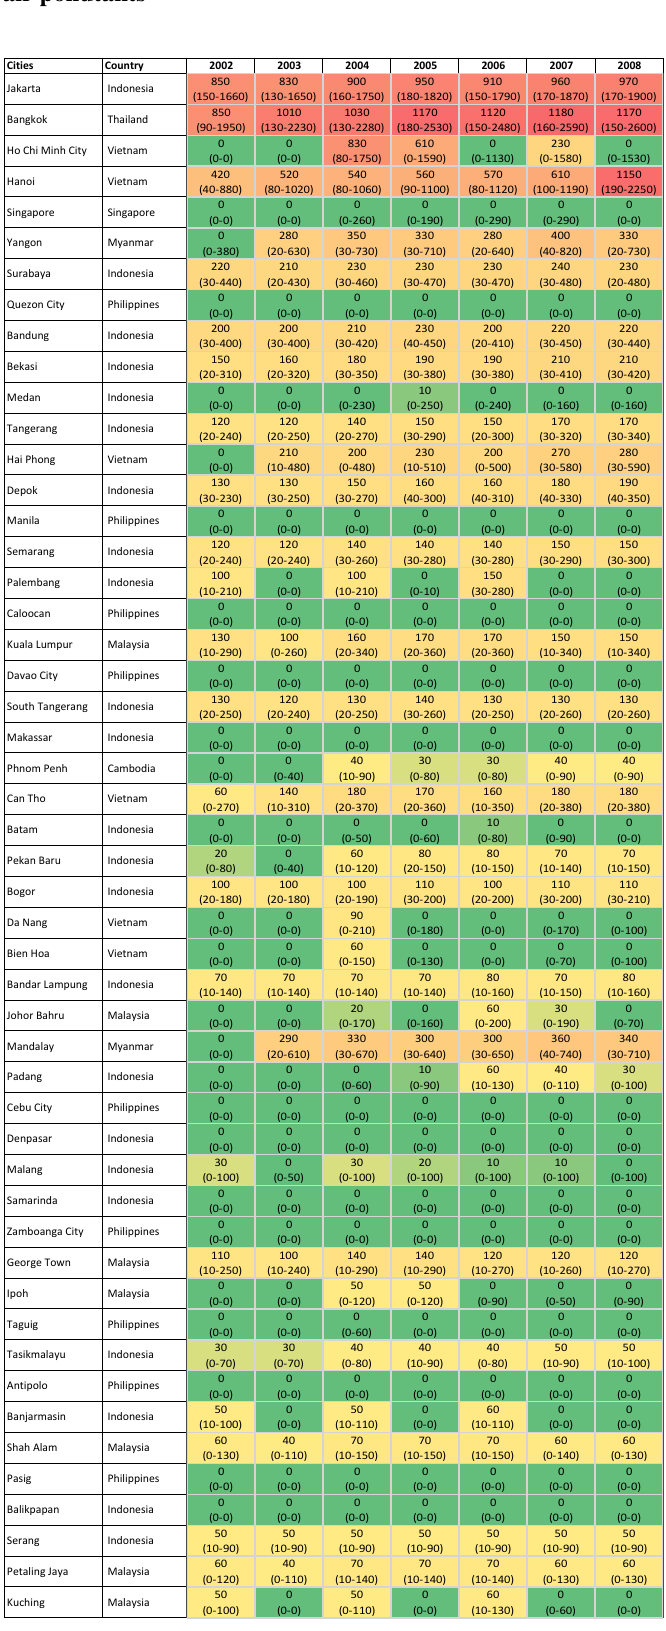
Figure 6. Premature mortality in different years from 2002 to 2008 and cities in Association of Southeast Asian Nations (ASEAN) due to exposures PM 2 . 5 in FFBB (95% confidence intervals). Colors from green to red represent relative number